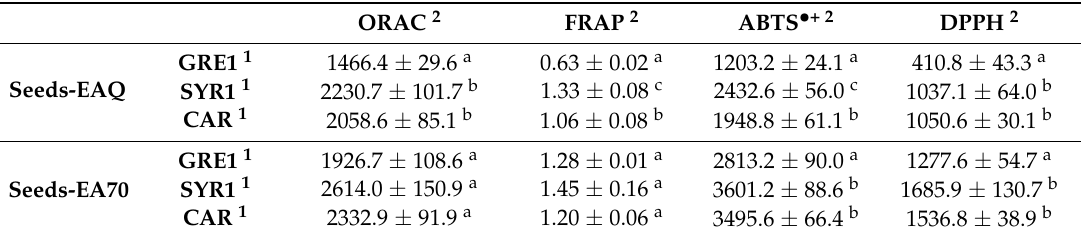
Table 1. Antioxidant activity characterization in EAQ and EA70 grape pomace seed extracts.